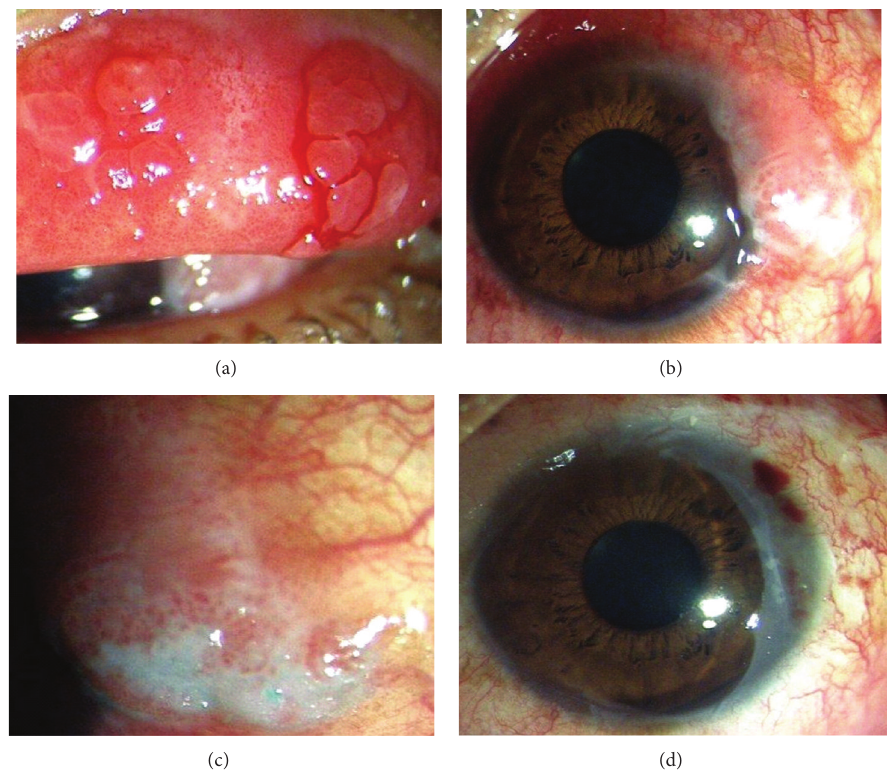
Figure 1: (a) Large cobblestone papillae on upper lid, left eye. (b) Limbal mass with vascular fronds on its surface. (c) A close-up view of the limbal mass—note the areas of keratinisation present on inferior border of the mass. (d) Amniotic membrane covering the conjunctival defect after excision